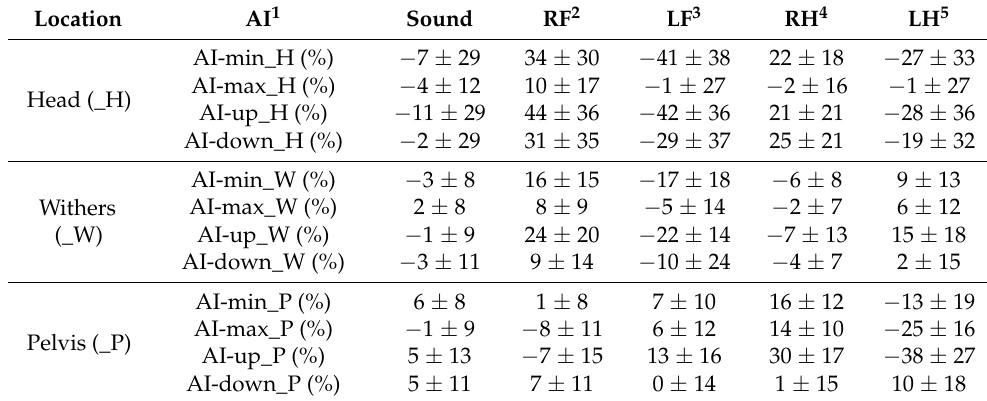
Table 2. Mean ± SD of AIs of the head, the withers and the pelvis in sound, RF lame, LF lame, RH lame, and LH lame horses trotting on a hard straight line.